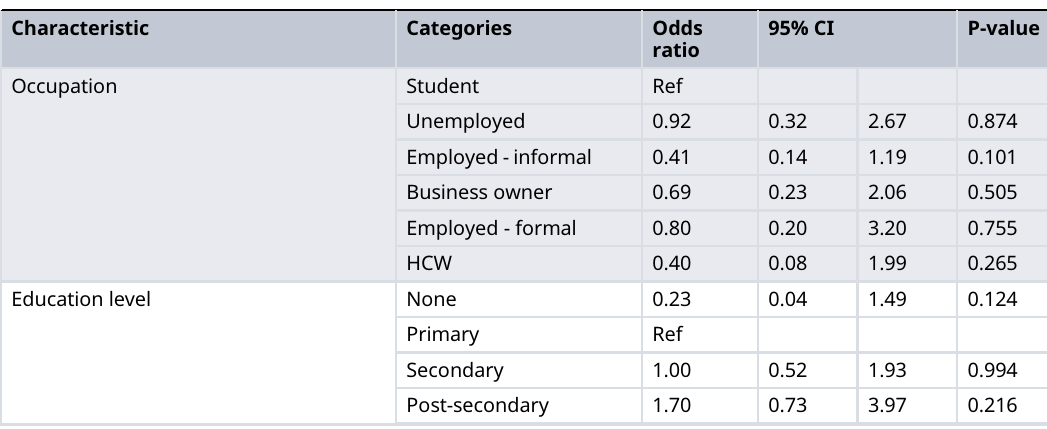
Risk factors for individual seropositivity Sex, area of residence, relationship to head of household, and underlying medical conditions were not significantly associated with individual seropositivity (Tables 3 and 4). Individual ’ s age and household size were the independent predictors of seroconversion. Relative to adults aged 20-29 years, young age groups (<20 years) had reduced odds of being seropositive. The odds of being seropositive were similar for older adults (age groups ≥ 30 years) compared to the reference group, 20-29 years. The odds for being seropositive among the elderly groups ( ≥ 60 years) were not different from the referent 20-29 years age group (adjusted odds ratio, aOR, 0.83 (95% CI, 0.19 – 3.64). Relative to those from medium-sized households (of three and four individuals), participants from large ( ≥ 5 persons) households had significantly increased odds of being seropositive, aOR, 1.98 (95% CI, 1.17 – 3.34), while those from small-sized households ( ≤ 2 individuals) had increased odds but not statistically significant, aOR 2.31 (95% CI, 0.93 –